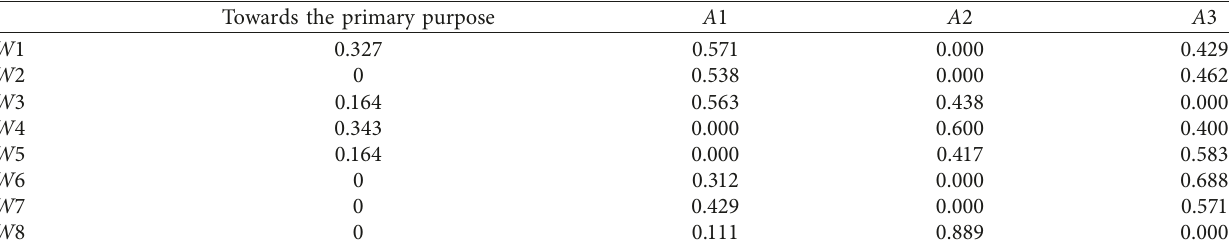
Table 9: Final weight of financing risks.